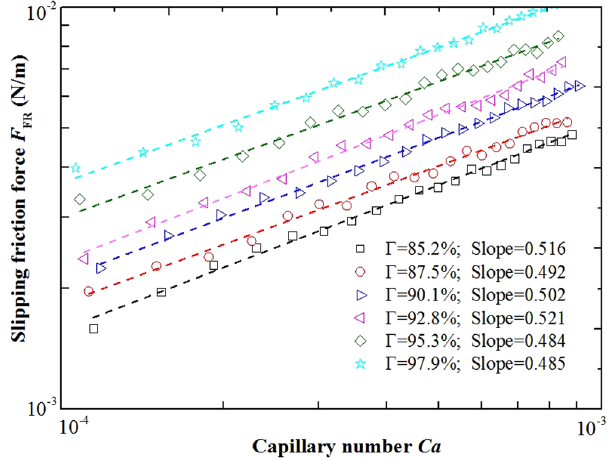
Figure 5. Foam slipping force F FR as a function of capillary number Ca for different foam qualities Γ . The slopes of the straight line fit are listed. Concentration of SDBS and silica nanoparticles of the foam were 0.1 wt% and 0.5 wt%,